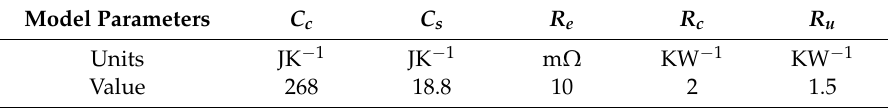
Table 1. Parameter declaration for the thermal model of Li-ion battery cell.